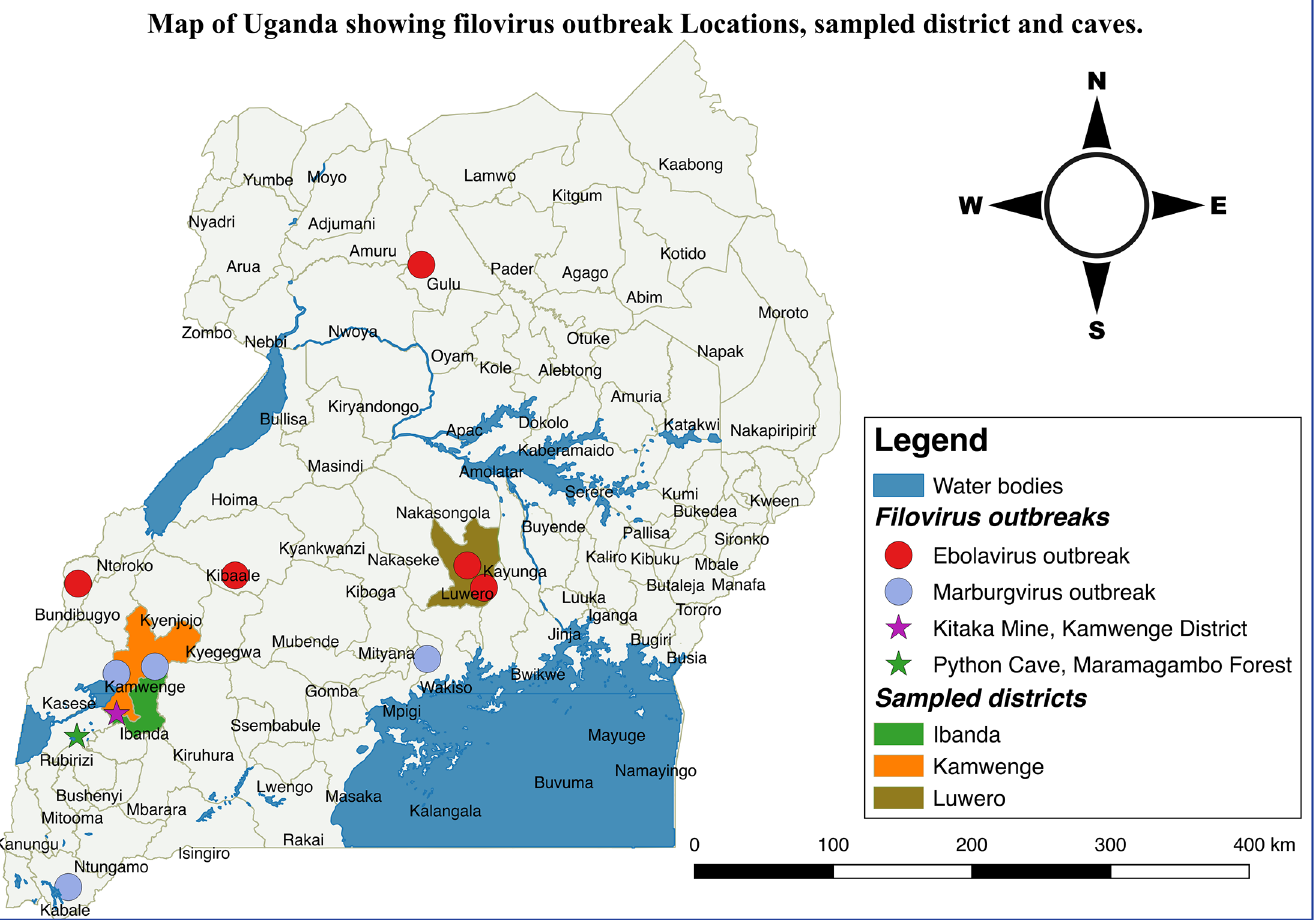
Fig 1. Map of Uganda showing Ebola and Marburg disease outbreaks and study districts (map developed in QGIS desktop software, the base layers from Uganda bureau of statistics-http://www.ubos.org/statistical-activities/gis/).